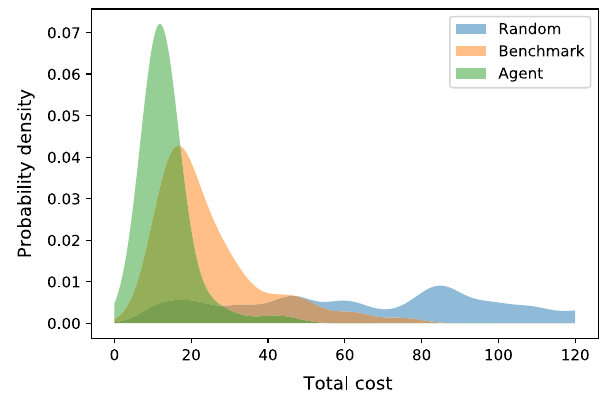
Fig. 5 Total cost (negative reward) after 100 successful episodes. For the random and benchmark policy, the success rate was around 60% (to achieve the objective within 40 experiments in total), whereas 94% was successful for the RL